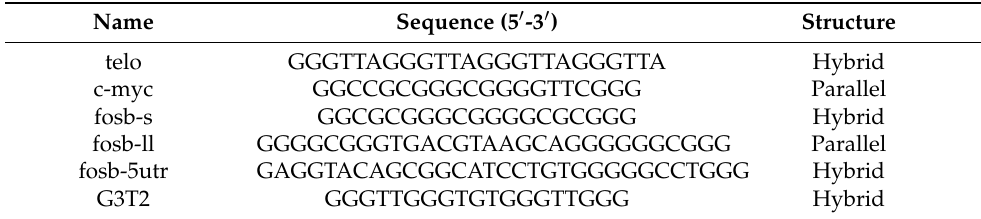
Table 1. The G4-forming sequences used in this